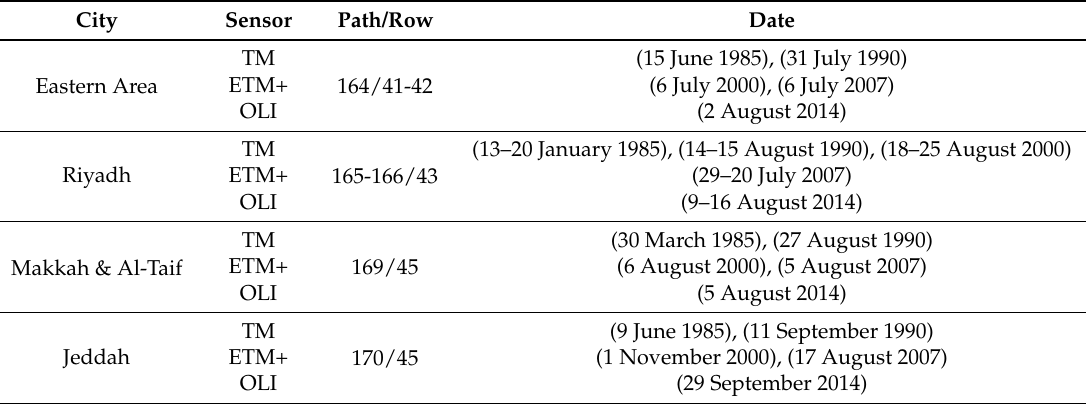
Table 2. Information of Landsat data used to classify land cover